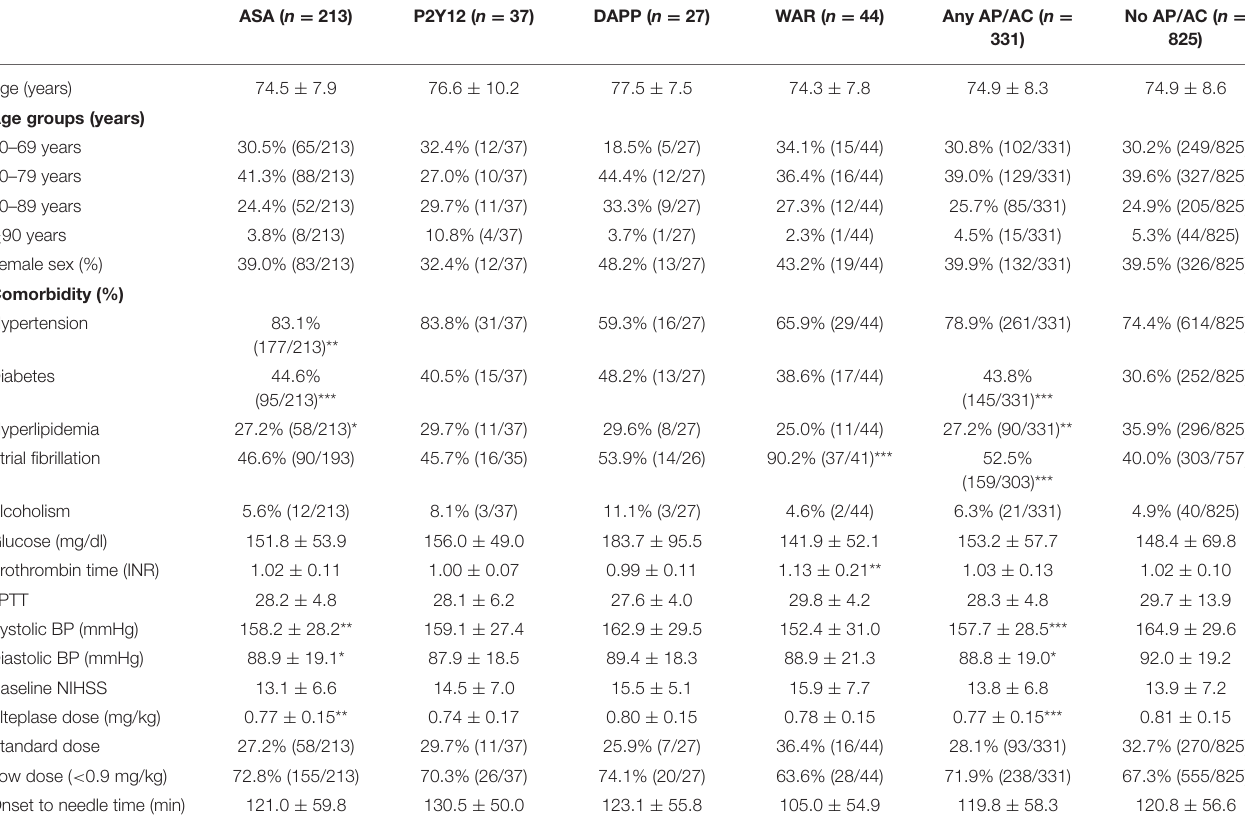
TABLE 1 | Characteristics of patients receiving antiplatelets and anticoagulants before intravenous thrombolysis (Total N =